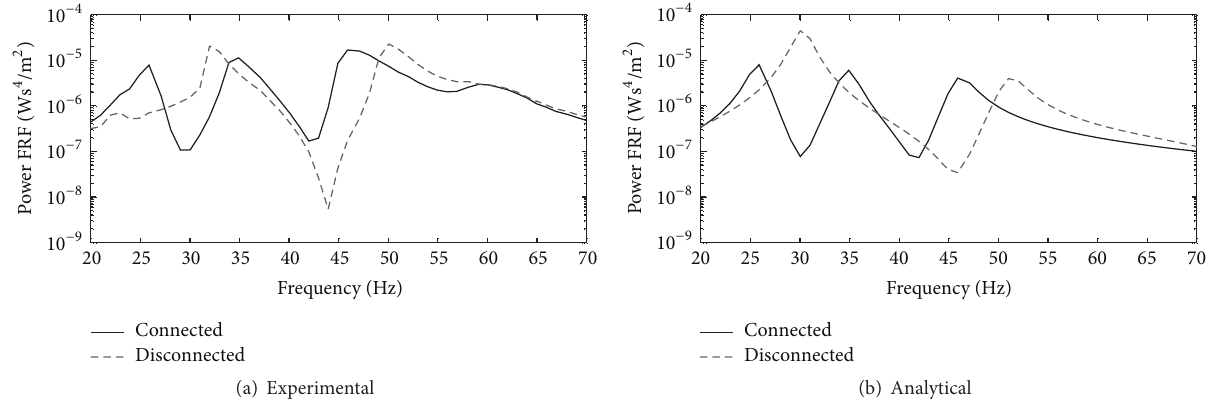
Figure 14: Power FRF for the three beams with and without springs and electrical connection in parallel to a resistive load of 1 k Ω : (a) experimental measurement, (b) analytical